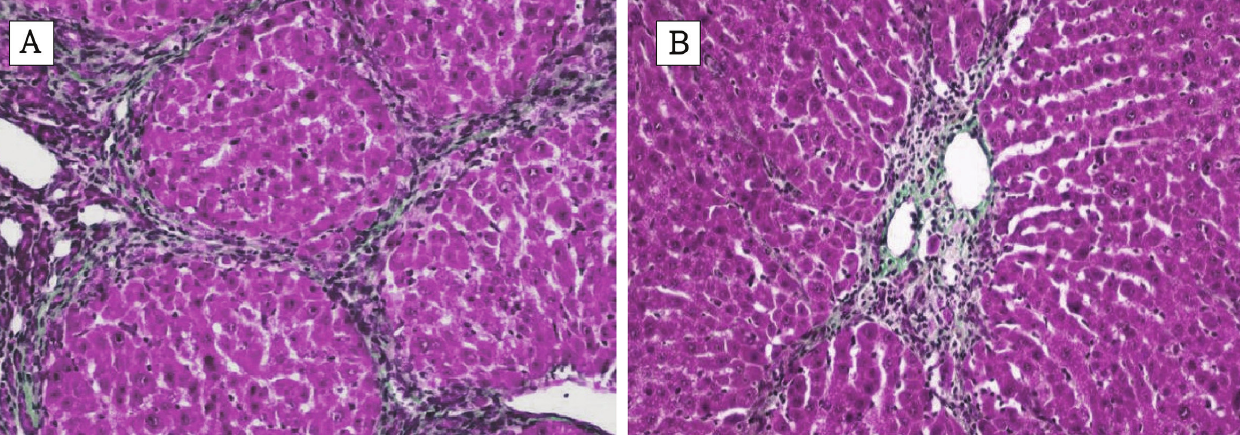
FIGURE 4 - Pictures showing the histopathological images of livers from different experimental groups: (A)TAA group-showing epithelial proliferation of bile duct and thick fibrous septa, (B)TAA+LES group-showing thin fibrous septa and mild epithelial proliferation of bile duct, Masson’s trichrome stain. Magnification